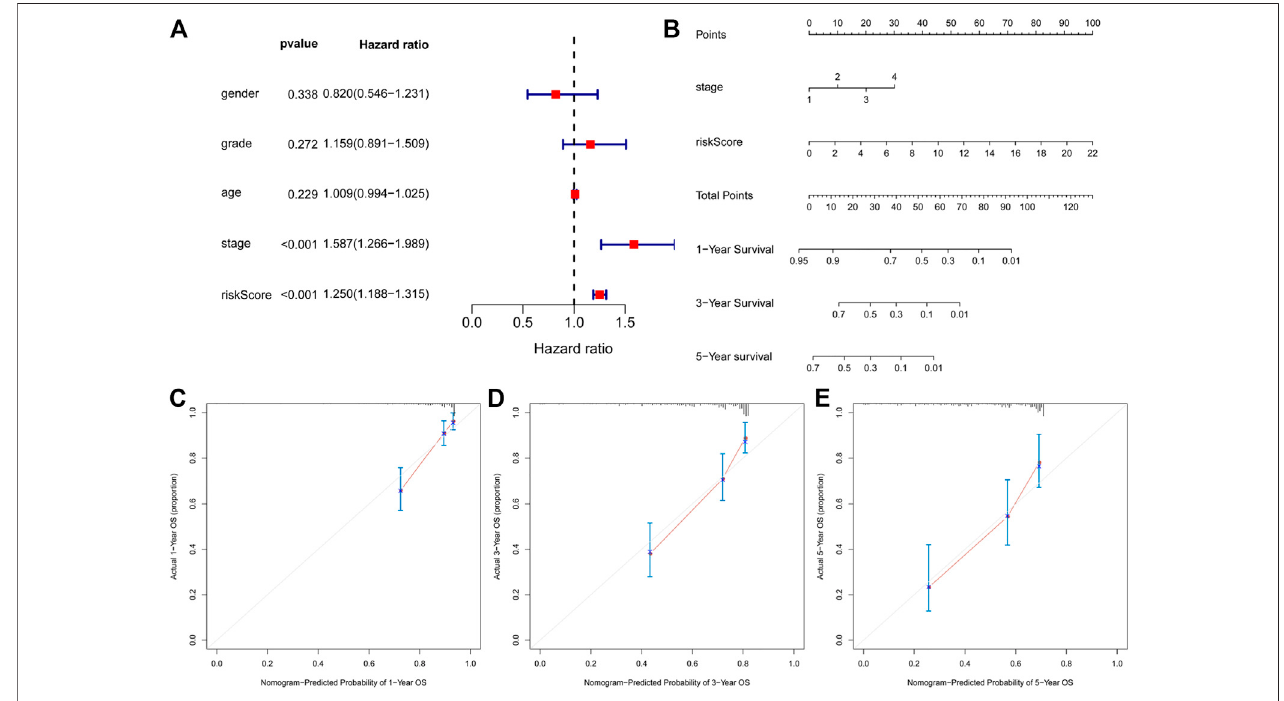
FIGURE5 | Construction ofa nomogram for predicting 1-,3- and 5-y survival ofHCC. (A) , Multivariate Cox regressionanalysesevaluated thecontribution ofeach variabletoHCCsurvivalintheTCGAcohort. (B) nomogramforpredicting1-,3-and5-ysurvivalrateofHCCpatientswasestablished. (C – E) ,Calibrationcurvesshowed the probability of 1- (C) , 3- (D) and 5-y survival (E) between the prediction and the observation in the TCGA cohort.